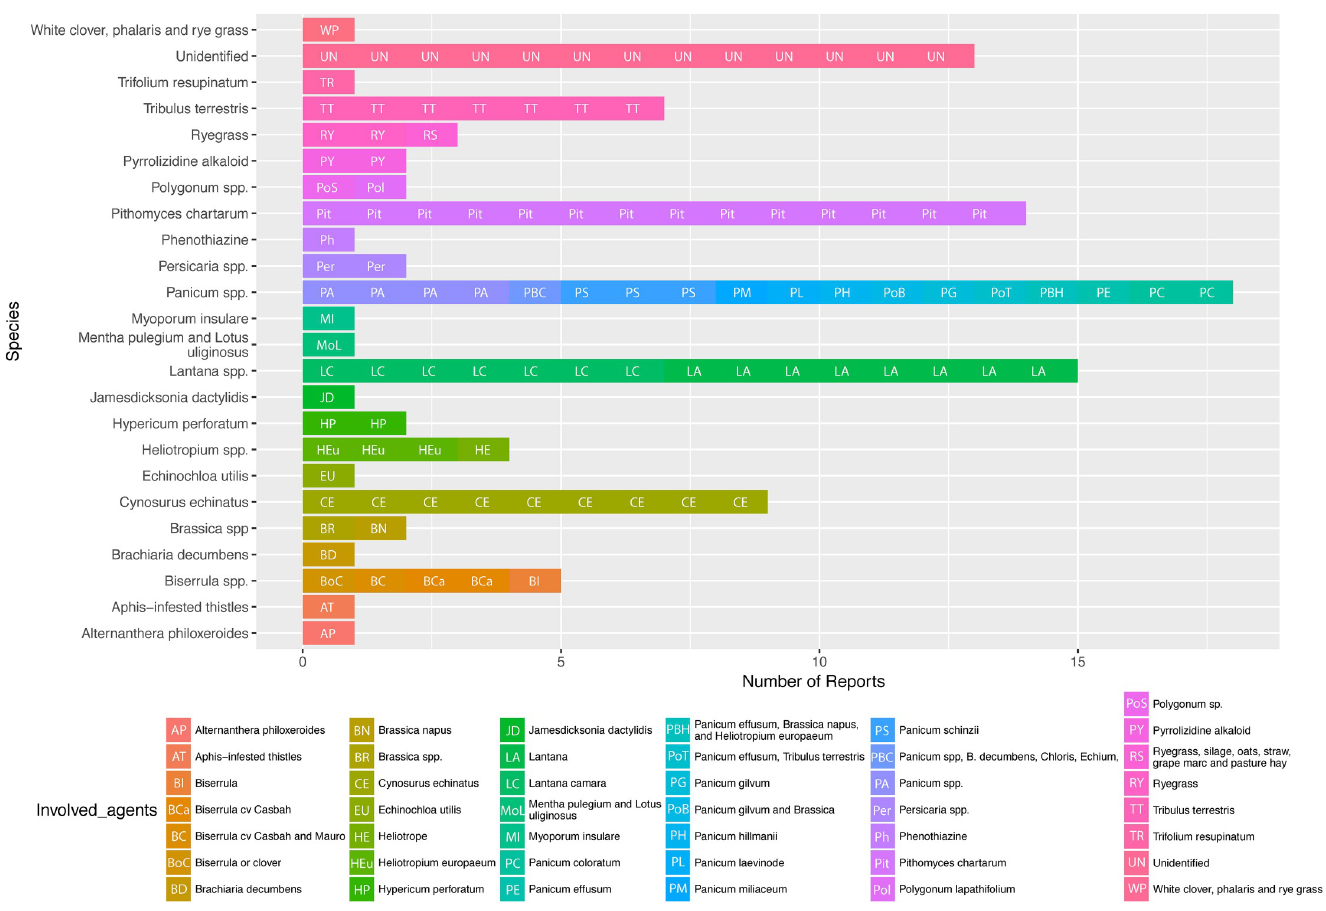
Fig 6. Plant species and other causative agents identified in published cases of photosensitisation in livestock in Australia.